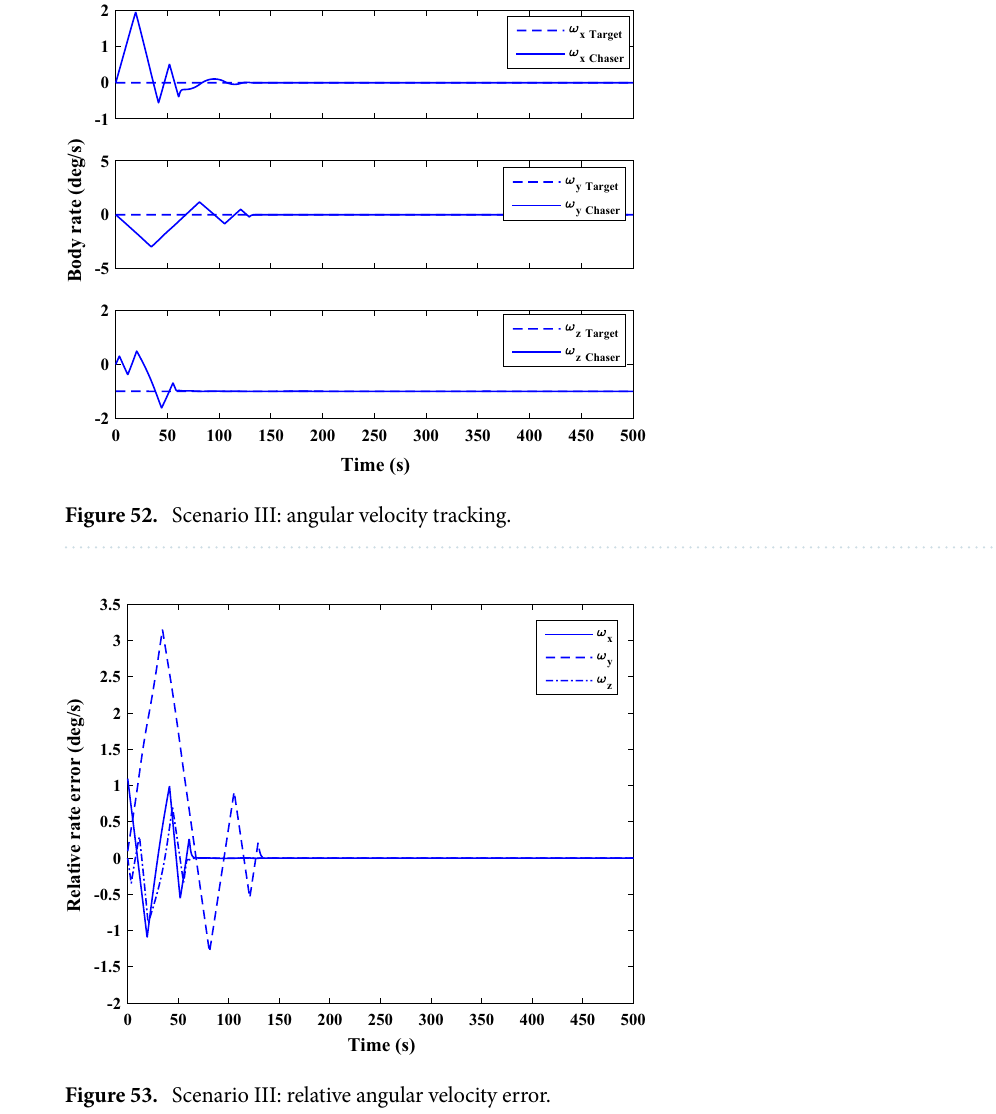
Figure 53. Scenario III: relative angular velocity error.